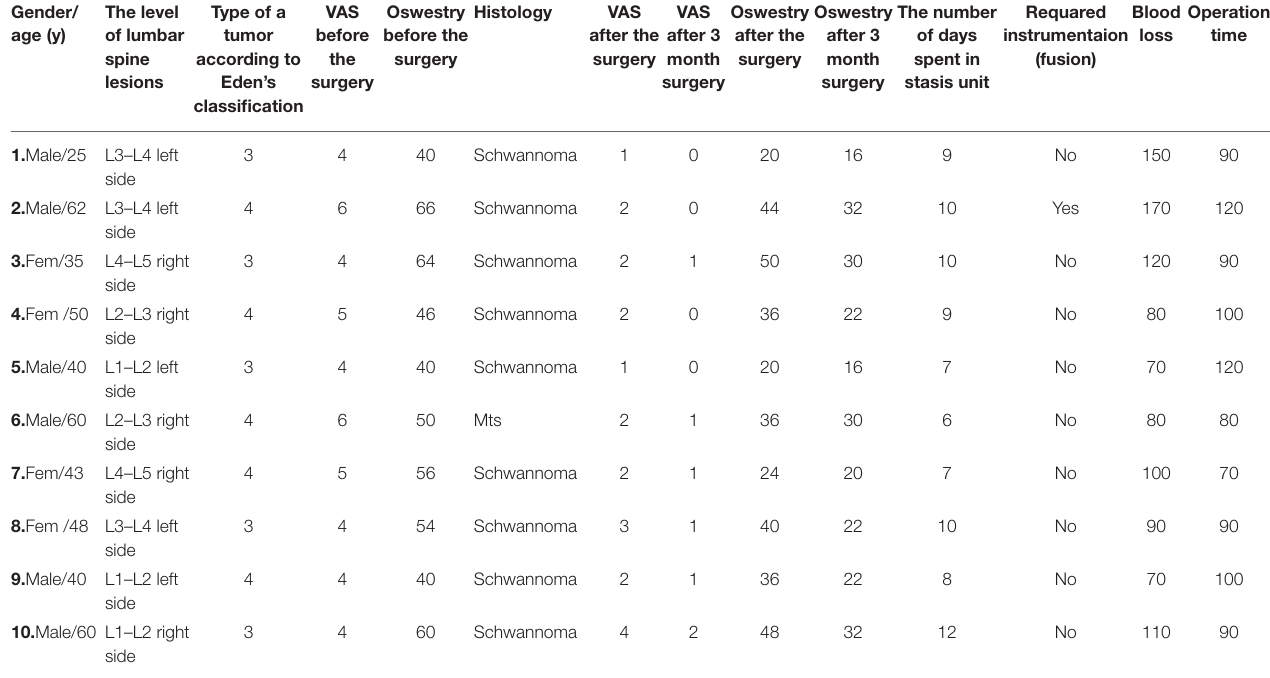
TABLE 2 | Results of performed surgery on 10 patients (Control group). Gender/ age (y)